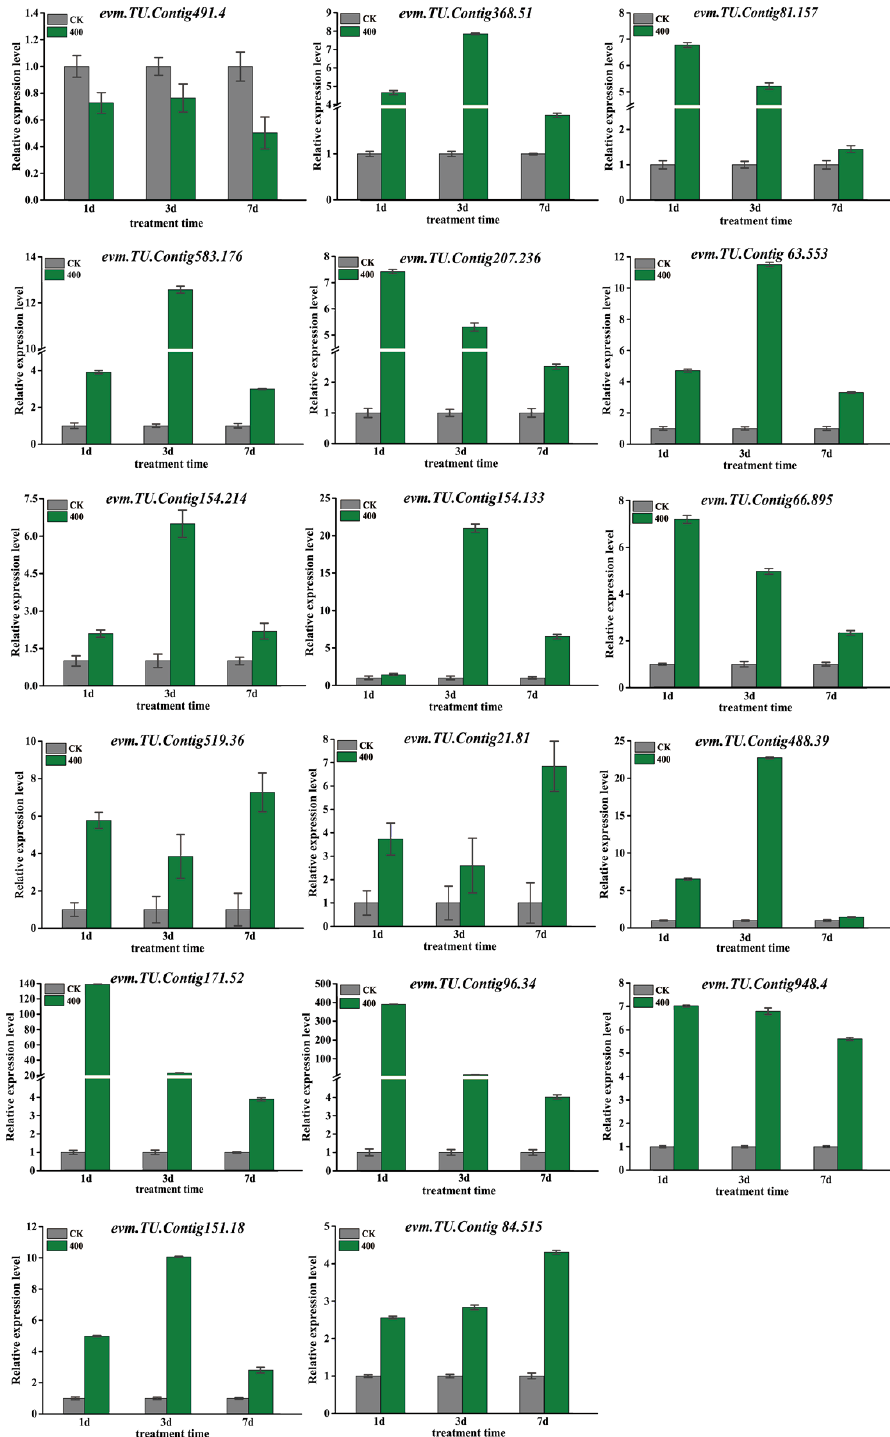
Figure 5. qRT-PCR verifies the relative expression levels of di ff erential expression genes (DEGs) at di ff erent times under aluminum stress. Transport ( evm.TU.Contig488.39, evm.TU.Contig519.36, evm.TU.Contig154.214, evm.TU.Contig154.133, evm.TU.Contig491.4, evm.TU.Contig63.553 ); transcription factor ( evm.TU.Contig96.34, evm.TU.Contig948.4, evm.TU.Contig151.18, evm.TU.Contig84.515 ); protein ( evm.TU.Contig368.51, evm.TU.Contig81.157, evm.TU.Contig 171.52, evm.TU.Contig583.176, evm.TU.Contig207.236, evm.TU.Contig66.895, evm.TU.Contig 21.81